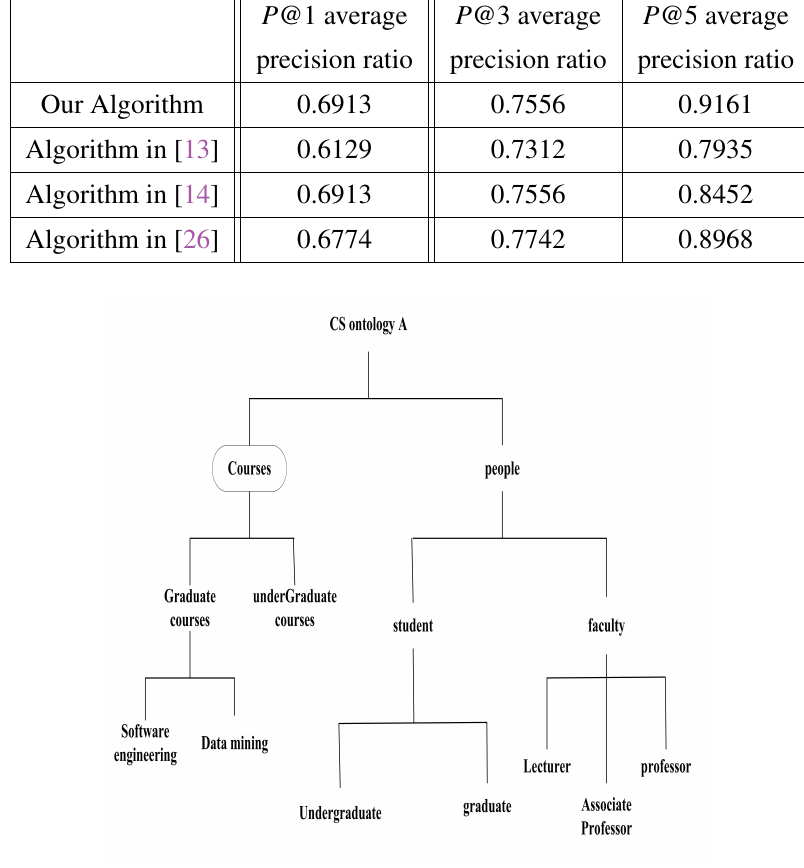
Fig. 8 “University” Ontology O 8 .